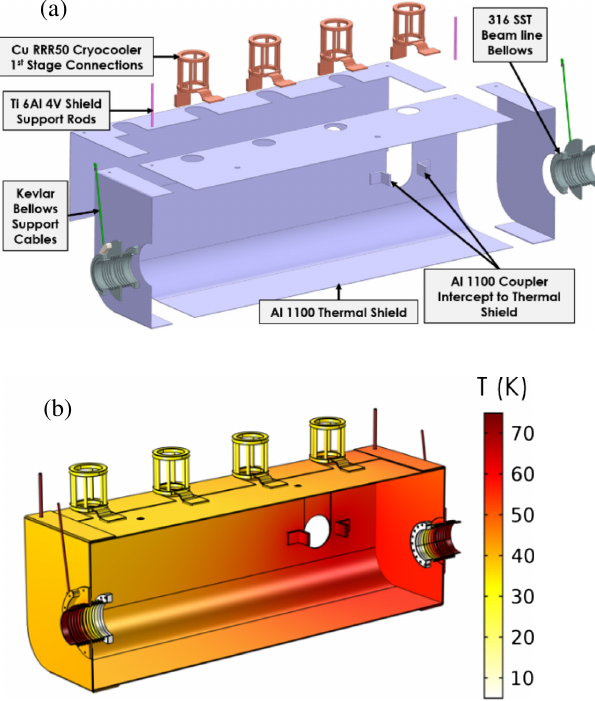
FIG. 22. (a) Thermal shield exploded view showing how the shield panels and components are assembled. (b) Thermal shield temperature distribution during steady-state operation of the